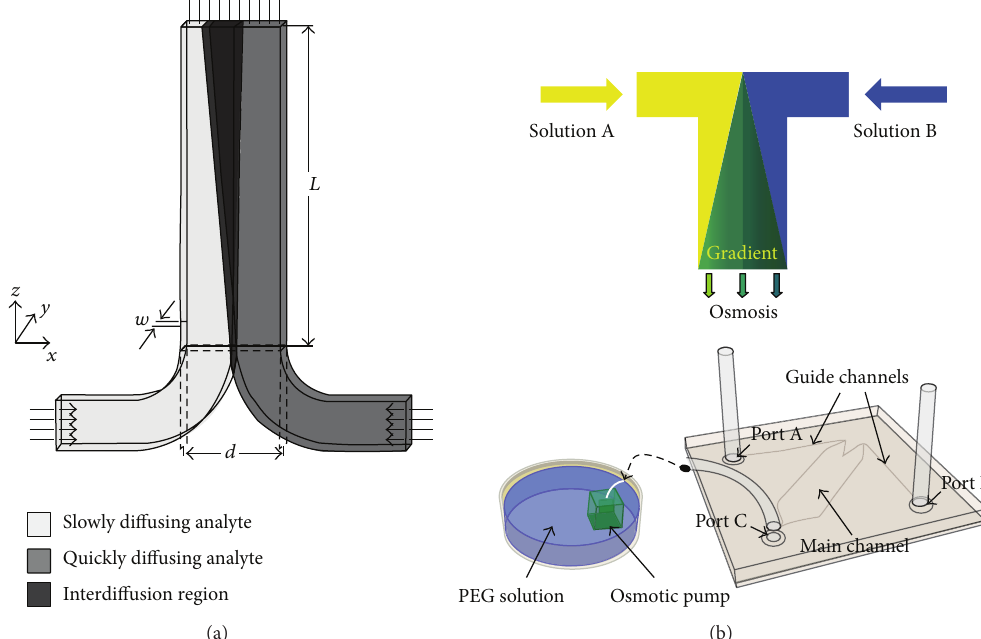
Figure4:(a)SchematicillustrationoftheT-channel.Duetolaminarflowcharacteristics,thetransportationofmoleculesbetweentwostreams in the channel was induced via diffusion. The two injected sample fluids have different diffusion coefficients; the asymmetry interdiffusion profile is generated in the microchannel. (b) Schematic representation of utilized microfluidic system with osmotic pump. The microchannel and osmotic pump were connected by a flexible tube and the flow is generated by the osmotic pump to generate concentration gradient profile along the